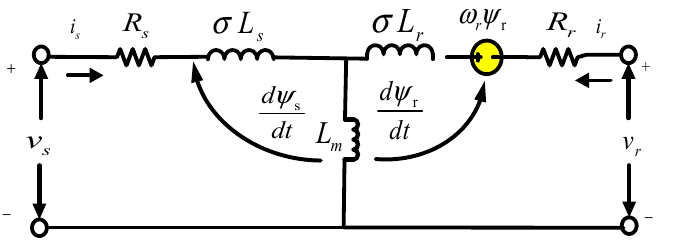
Figure 2. DFIG-equivalent circuit diagram for transient analysis in a stationary reference frame.